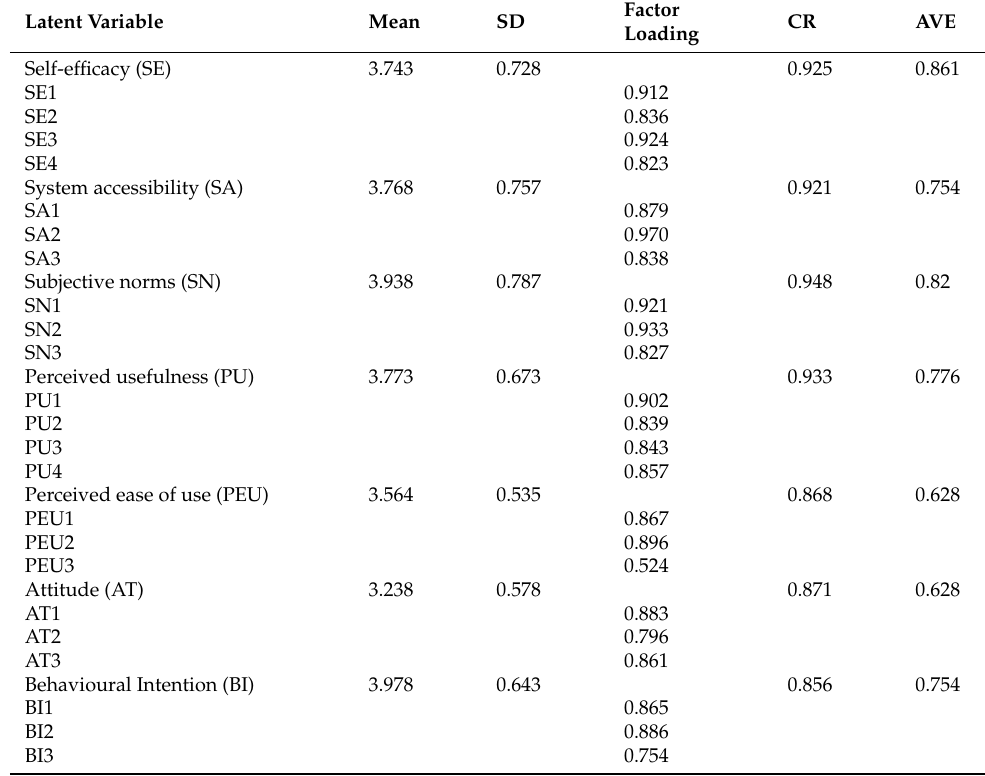
Table 2. Results of the Measurement